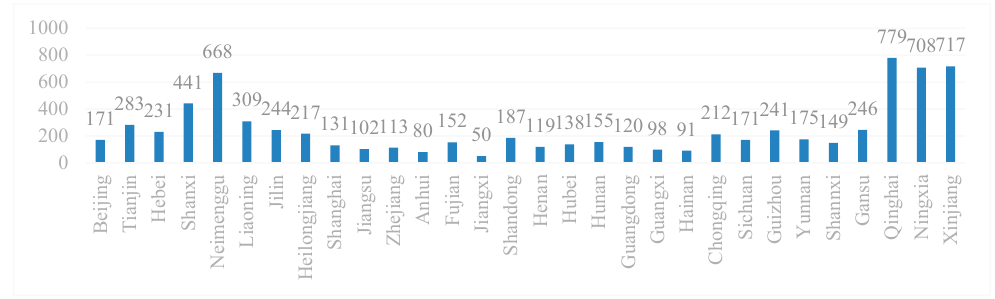
Figure 1. Annual average values of energy intensity of human well-being (EIWB) in each region. GeoDa was used to draw spatial quartile maps of EIWB to visually analyze the spatial distribution of EIWB in China from 2005 to 2016. Due to limited space, the spatial distribution of EIWB in 2006, 2011 and 2016 is presented at 5-year intervals to ensure simplicity. In Figure 2a–c are the spatial quartile maps of China’s EIWB in 2006, 2011 and 2016 respectively.